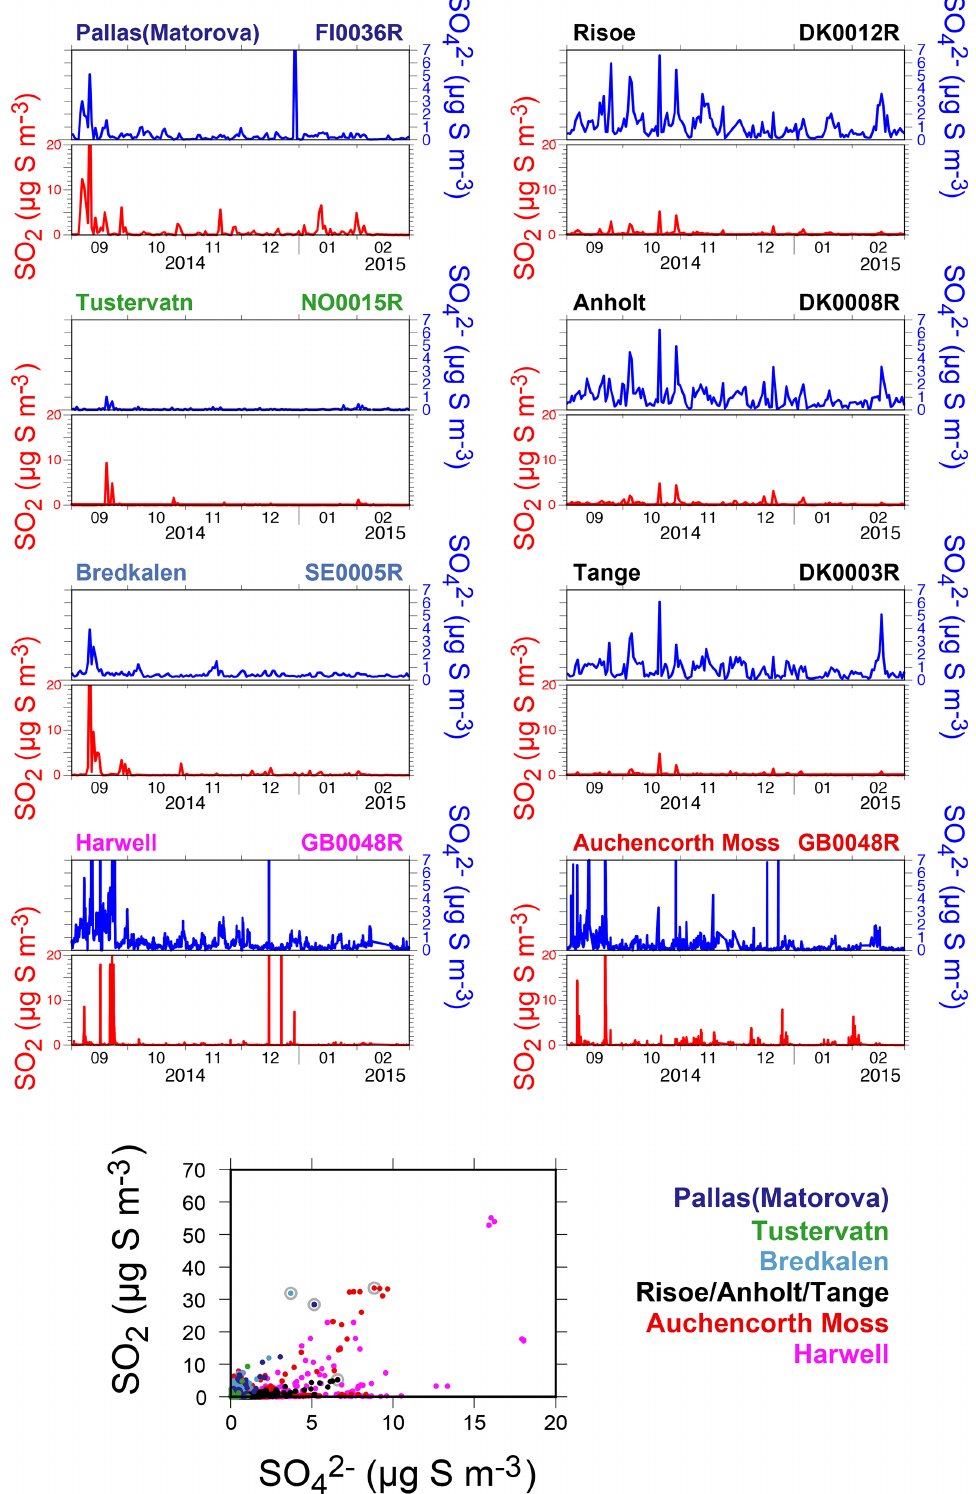
Figure 14. Time series (top) and scatter plot (bottom) of ground-level mass concentrations (in µgSm − 3 ) of SO 2 and corrected PM 10 SO 2 − (i.e. non-marine SO 4 ) covering the Holuhraun eruption from September 2014 to February 2015, at selected EMEP stations in Scandinavia and Great Britain clearly impacted by the eruption. Grey circles in scatter plot indicate data points selected for plume age estimation in Fig.